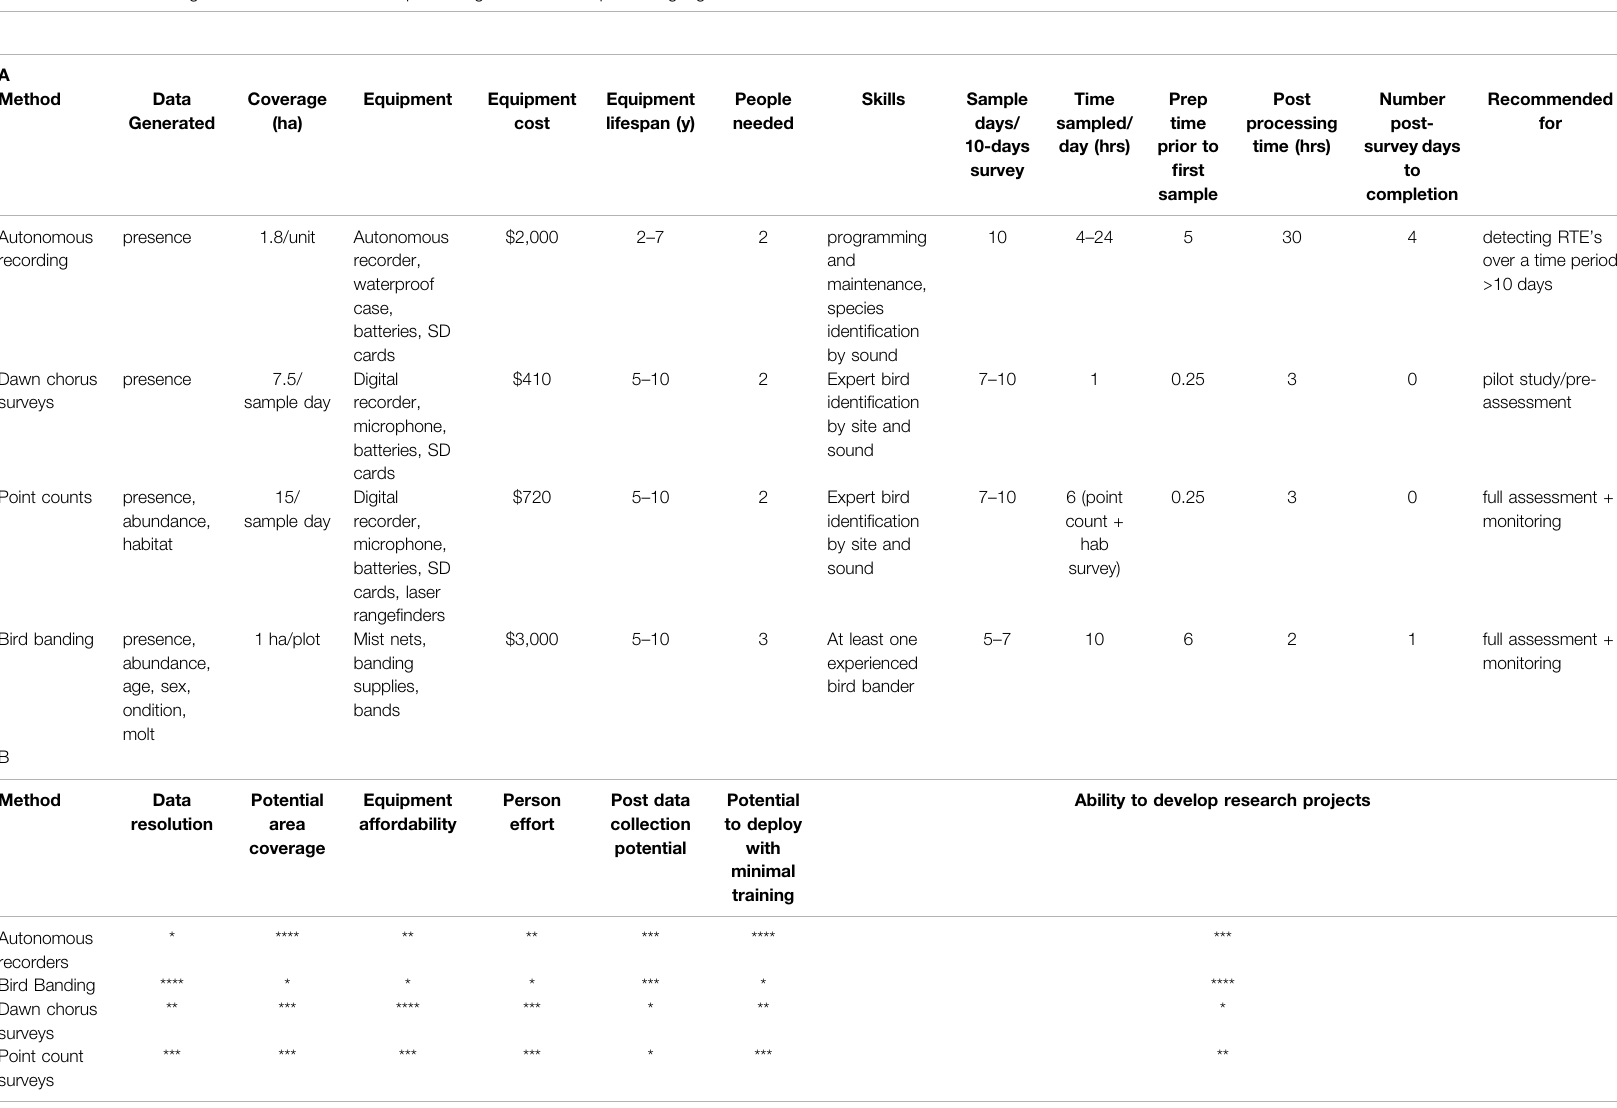
TABLE5| Methodsdetails.A.Equipmentlistsandcostsdonotincludebasic fi eldsuppliesneededforornithologicalworksuchasbinocularsand fi eldnotebooks/datasheets, etc.Equipmentlifespanisanestimatebasedon the lifespan of gear used in the surveys described in this study. Gear was subjected to hot and humid conditions during fi eld deployment, then cleaned and stored in secure, dry storage. Post processing estimates are basedonahypothetical10-days surveytrip(not includingtraveltime to/from surveylocation).Thisprocessing timewould increase forautonomous recordersifmore than10recorders aredeployed. AllpricesareinUSD.B. Rank of methods. Rankings are from * to **** with * representing low and **** representing high for the variables